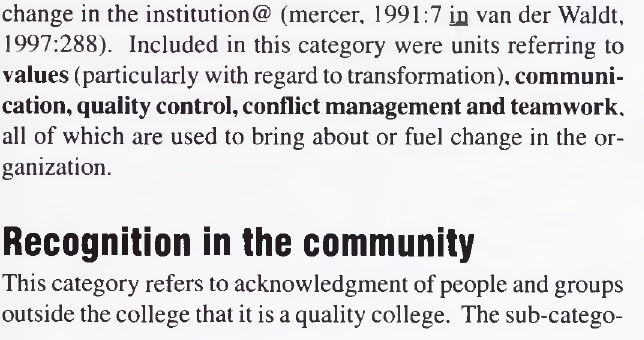
Figure 1 0 : Educational programme,